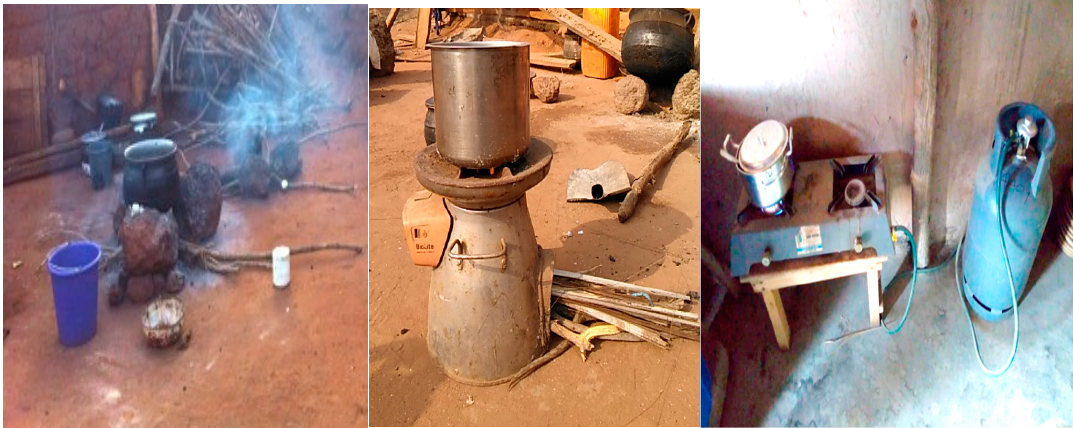
Figure 1. Three-stone (left), BioLite (middle) and (right) liquefied petroleum gas (LPG) cookstoves.